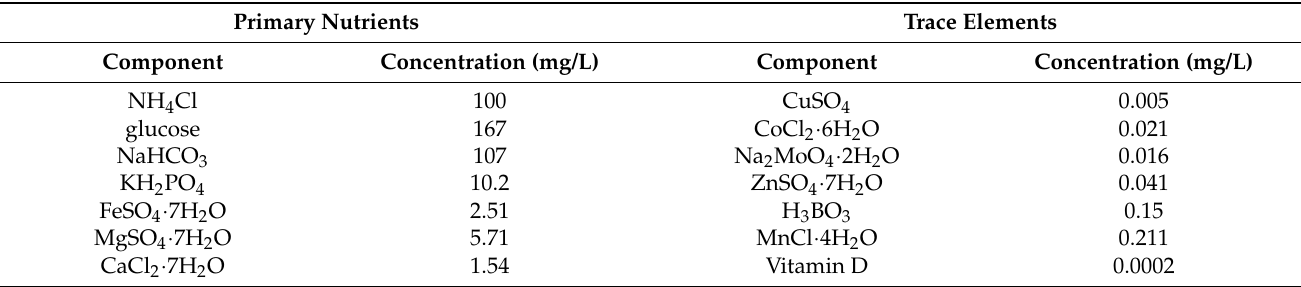
Table 1. Component of synthetic wastewater.